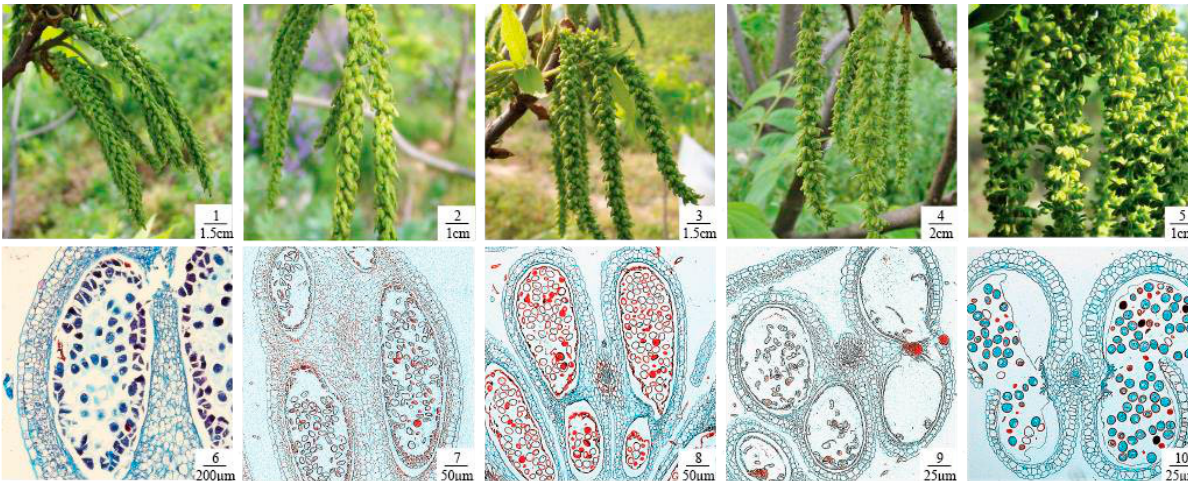
Figure 3. Internal and external structure of staminate flower differentiation in pecan. 1) Inflorescence elongated, angle between bracts and inflorescence axis around 5°. 2) Anthers dilated, bracts open, angle between bracts and inflorescence axis 10°. 3) Anther differentiation, angle between bracts and inflorescence axis 45°. 4) 4–6 anthers visible, angle between bracts and inflorescence axis 60°. 5) Anthers yellow- green, fully visible, turned outward, bracts open and inflorescence axis angle greater than 90°. 6) Microspore mother cells in metaphase nuclei and the nucleus polarized. 7-8) mononuclear microspores moved aside, and the tapetum degraded. 9) Microspore mother cells abort- ed, pollen wall degradation. 10) With the disintegration of the anther wall in each chamber, the pollen sac cracks and mature pollen was